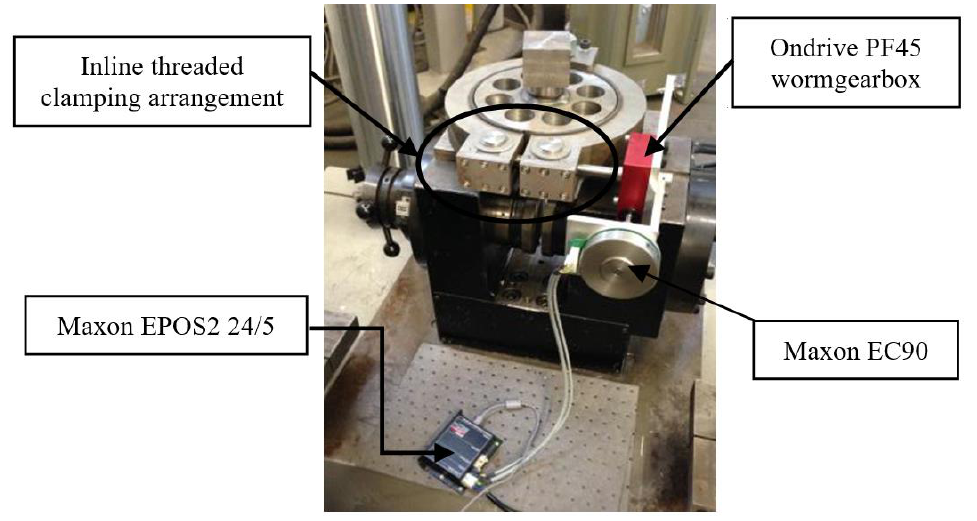
Figure 16. Electro-mechanical brake testing platform.